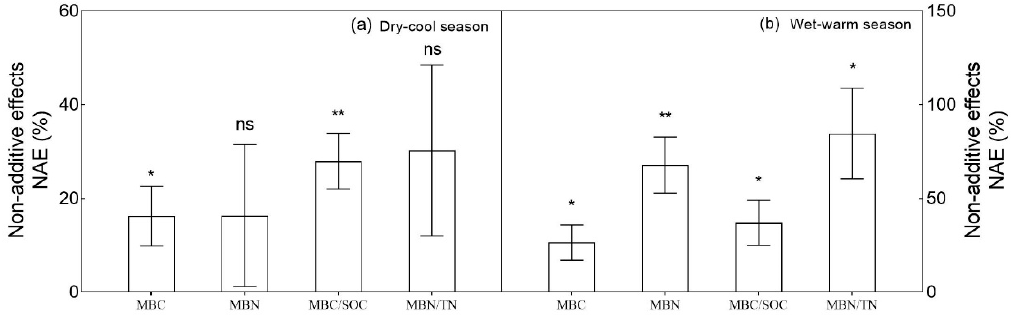
Figure 3. Not-additive effects of mixed plantation on soil microbial biomass in the dry-cool season ( a ) and wet-warm season ( b ).